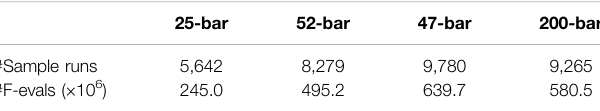
TABLE 3 | Summary of the computations for the 4 test problems, expressed as the number of sample runs and number of objective function evaluations (throughout the simulation).